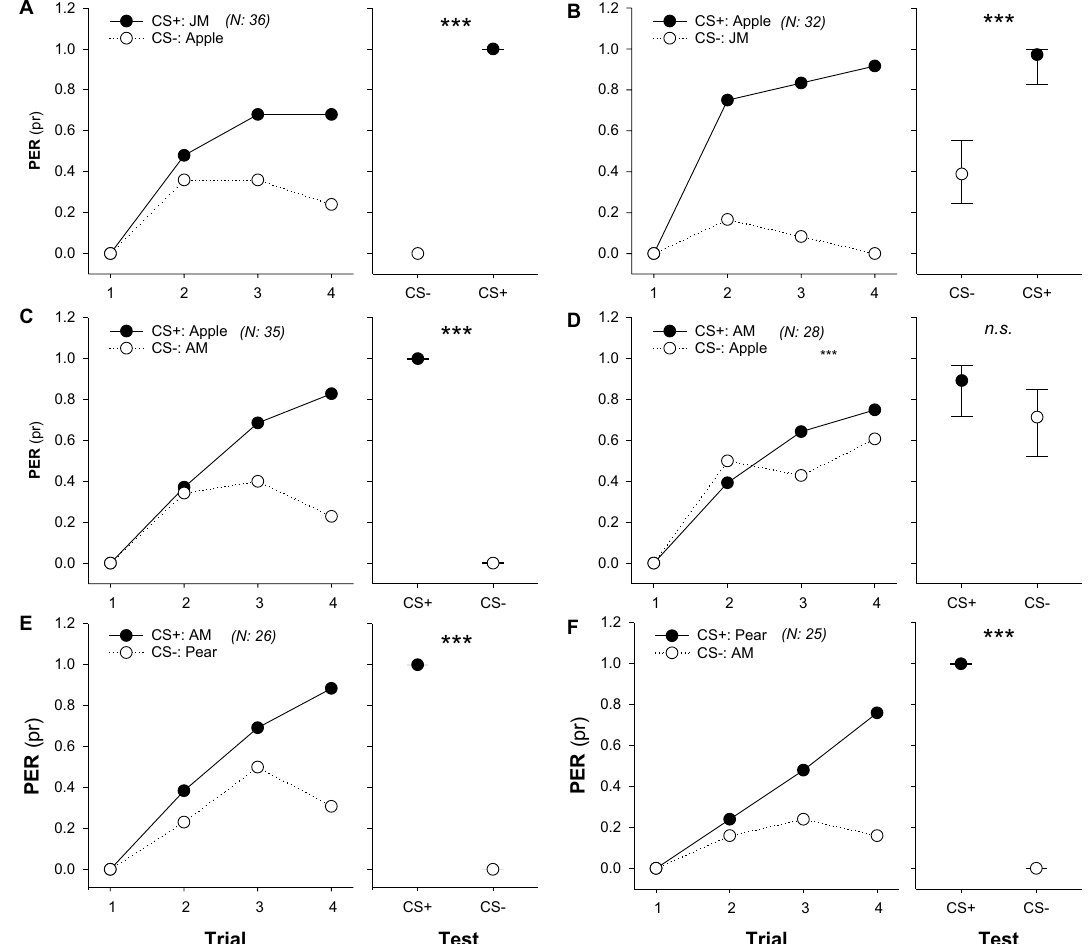
Figure 2. Discrimination between mimic odours and natural floral scents. ( A , B ) Discrimination was evaluated towards the single presentation of the apple natural floral odour and the jasmine mimic (JM) (right panels) after a differential proboscis extension reflex (PER) conditioning (left panel), where both apple natural odour and JM were used as rewarded (CS+) and non-rewarded stimulus (CS−). Asterisks indicate significant differences between tested odours (***, p < 0.001). ( C , D ) Differential PER conditioning between the apple natural floral odour and the apple mimic (PM), where both odours were used as rewarded (CS+) and non-rewarded stimulus (CS−). No difference (n.s.) at test indicates that bees could not discriminate between AM and the unrewarded apple natural scent ( D ). ( E , F ) Differential PER conditioning between the pear natural floral odour and the apple mimic (AM), where both odours were used as rewarded (CS+) and non-rewarded stimulus (CS−). Asterisks indicate significant differences between tested odours (***, p < 0.001) showing that bees could discriminate between AM and the pear natural scent. The experimental subjects were all foraging bees naïve for the CSs that had no access to any pear or apple tree. Numbers between brackets indicate sample size. Circles indicate the proportion of PER and bars (in test) show the 95% confidence intervals. Package ‘emmeans’, version 1.8.0. https:// github. com/ rvlen th/ emmea